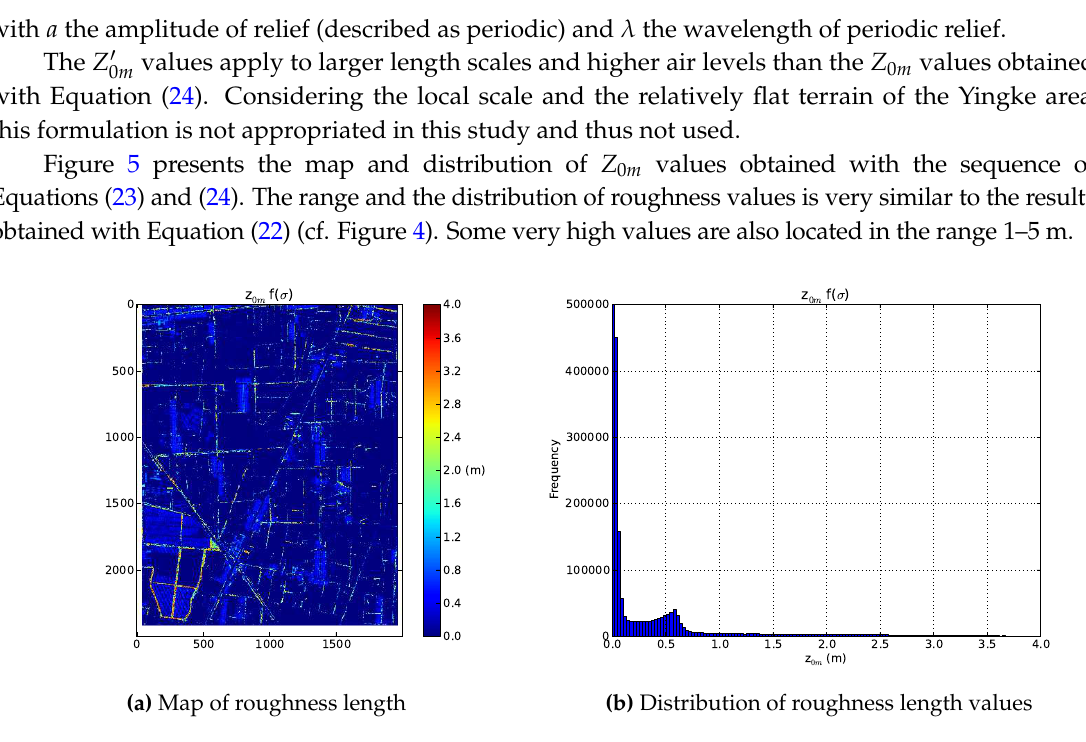
Figure 5. ( a ) Map and ( b ) frequency distribution of roughness length for momentum transfer values over the Yingke oasis station retrieved from σ h